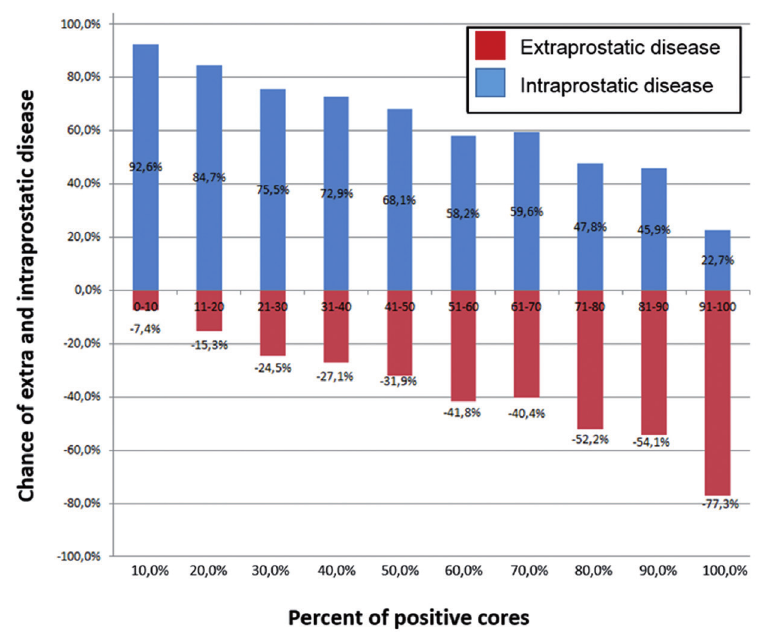
Figure 1 - Chance of extraprostatic disease according to the percentage of positive biopsy cores for all patients.